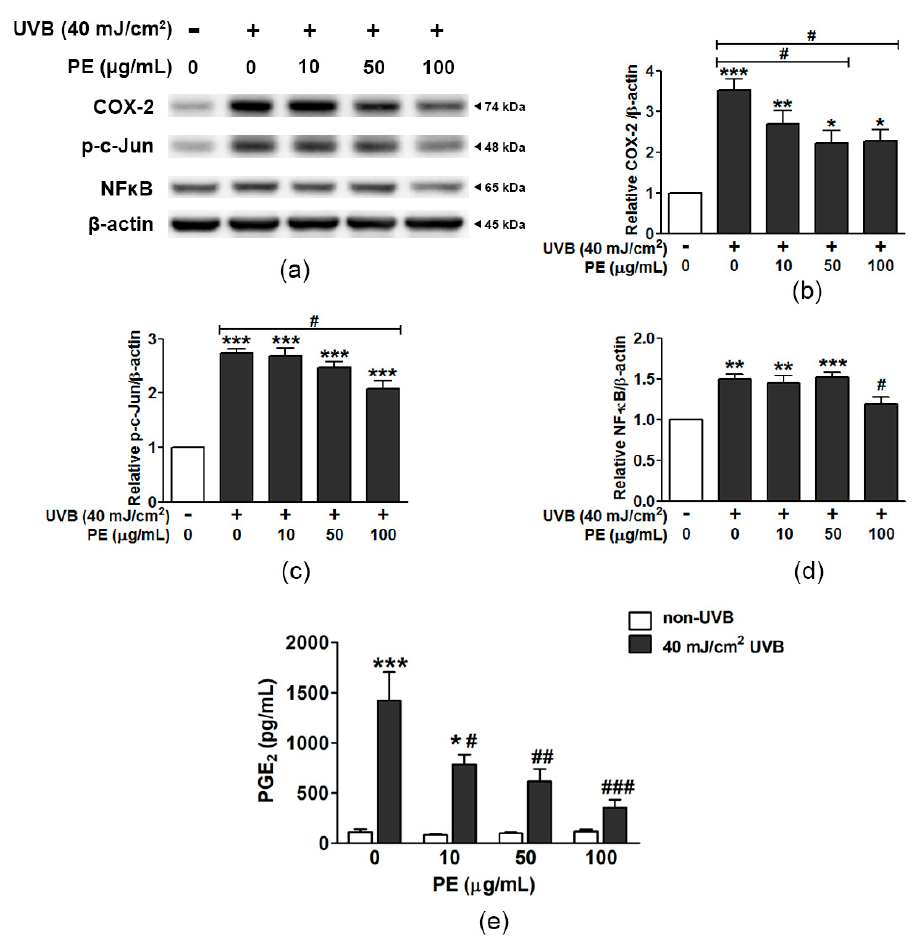
Figure 5. The effects of PE and UVB on the activation of COX-2, p-c-Jun, NF- κ B, and Nrf2. ( a ) The protein bands of COX-2 and cyt c in relation to β -actin. The relative ratios of the band intensity for ( b ) COX-2/ β -actin, ( c ) p-c-Jun/ β -actin, and ( d ) NF- κ B/ β -actin; ( e ) the levels of prostaglandin E 2 (PGE 2 ). The data are shown as the mean ± SEM ( n = 3). *, p < 0.05; **, p < 0.01; and ***, p < 0.001, when compared to the non-UVB group; # , p < 0.05; ## , p < 0.01; and ### , p < 0.001, when compared to the UVB-exposed group.